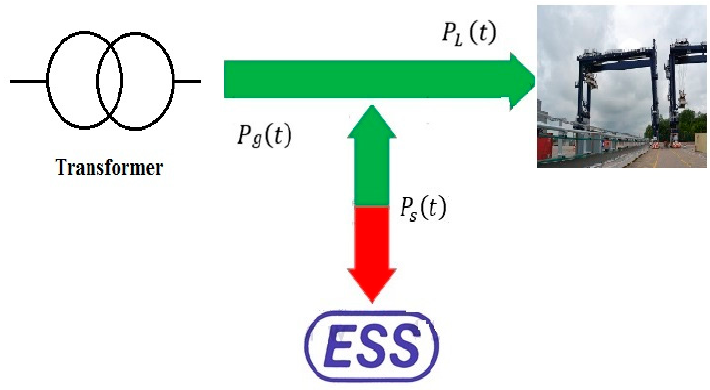
Figure 1. Crane system: ( a ) electrified RTG crane at the Port of Felixstowe; ( b ) an example of the actual electrified RTG crane demand for a specific day.